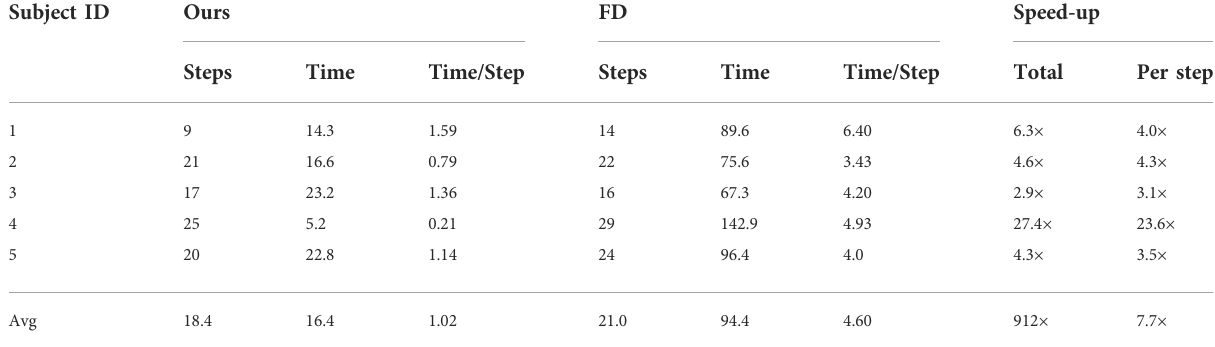
TABLE 3 Performance of our method, using differentiable biomechanics, compared with state-of-the-art optimization using fi nite differences (FD) for the computation of gradients. All timings are measured in minutes. We report the number of steps of each optimization, the total time, the time per step, the total speed-up, and the speed-up per